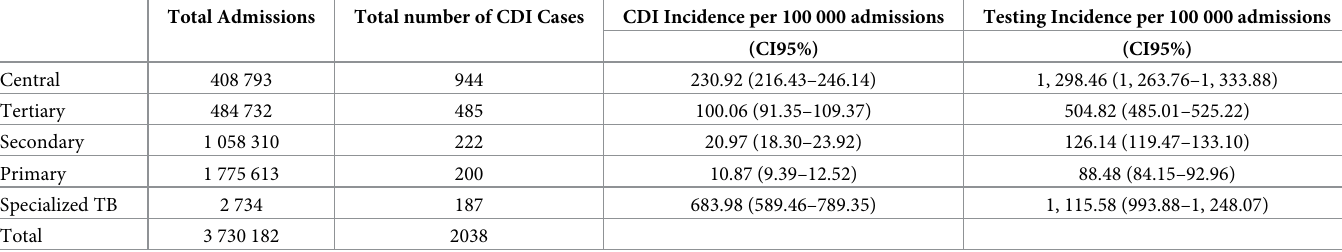
Table 2. Incidence of CDI, CD testing and positivity rate by level of care per 100 000 admissions.